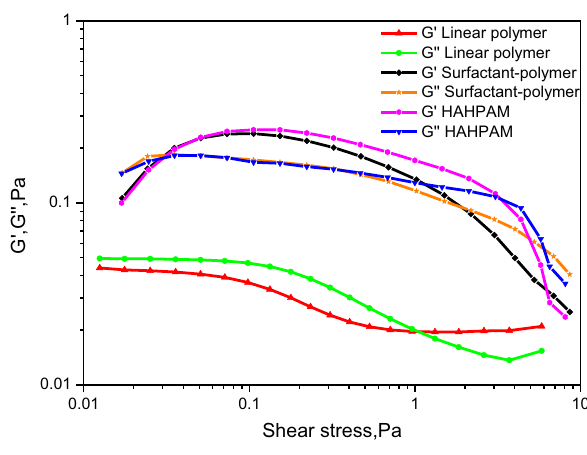
Fig. 7 Storage modulus ( G ′ ), and viscous modulus ( G ″ ), plot- ted as a function of shear stress for HAHPAM, linear poly- mer, and surfactant–polymer in brine (salinity = 9000 mg L −1